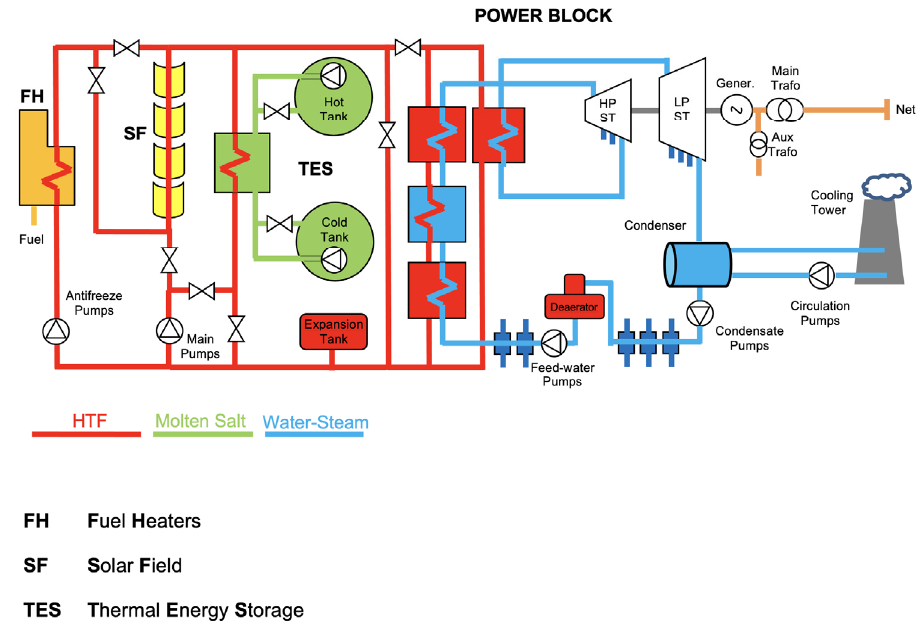
Figure 1. Generic parabolic trough layout.